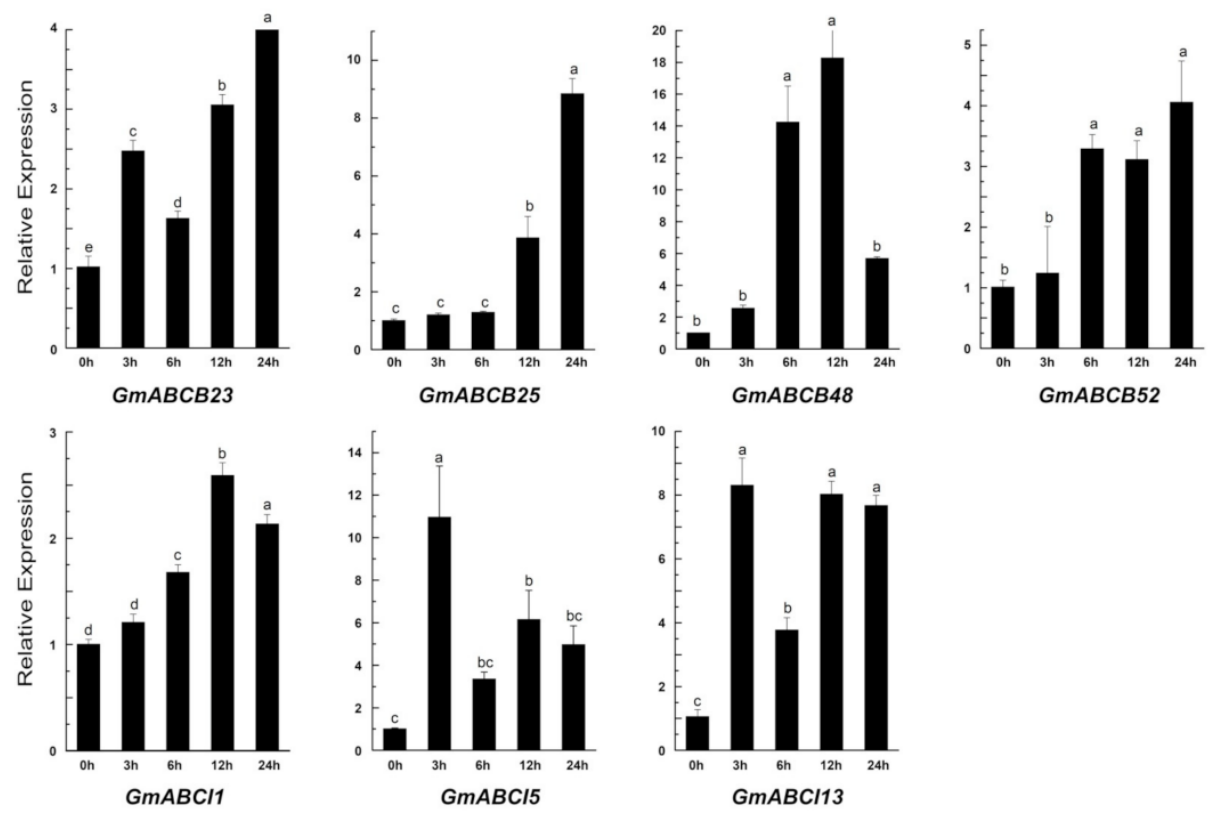
Figure 9. Time-dependent expression of seven GmABC gene expressions. The roots of soybean exposed to a 0.5 mM CaCl 2 solution (pH 4.5) containing 50 µ M AlCl 3 for 0, 3, 6, 12, and 24 h were used for analysis. The expression was determined by qRT-PCR and β -tubulin was used as an internal control. The treatment without AlCl 3 (0 µ M AlCl 3 ) was used for control. All data shown are means ± SD of three biological replicates. Bars with different lowercase letters indicate significant differences ( p <